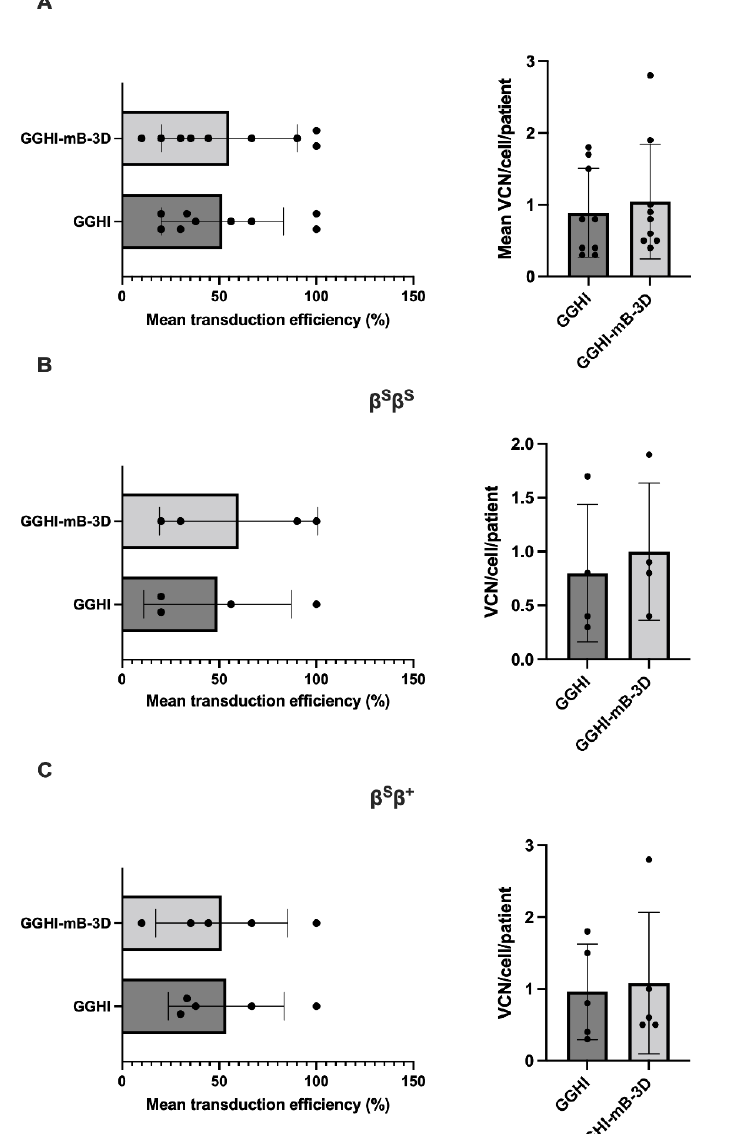
Figure 4. Transduction efficiency and VCN/cell demonstrated by γ -globin LVs in SCD CD34 + cells: ( A ) Scatter plots showing mean percentage of transduction efficiency (left) and mean VCN/cell/patient (right) across all patients and following transduction with GGHI and GGHI-mB-3D LVs at MOI 100. GGHI leads to 52 ± 31.5% and GGHI-mB-3D to 55 ± 35% transduction efficiency ( p = 0.82, n = 9, unpaired two-tailed t -test). Mean VCN/cell/patient for GGHI and GGHI-mB-3D is 0.89 ± 0.62 and 1.04 ± 0.8, respectively ( p = 0.65, n = 9, unpaired two-tailed t -test). ( B ) Scatter plots showing mean percentage of transduction efficiency (left) and mean VCN/cell/patient (right) in the β S β S patient cohort and following transduction with GGHI and GGHI-mB-3D LVs at MOI 100. GGHI leads to 49 ± 38% and GGHI-mB-3D to 60 ± 40.82% transduction efficiency ( p = 0.71, n = 4, unpaired two-tailed t -test). Mean VCN/cell/patient for GGHI and GGHI-mB-3D is 0.8 ± 0.64 and 1 ± 0.66, respectively ( p = 0.67, n = 4, unpaired two-tailed t -test). ( C ) Scatter plots showing mean percentage of transduction efficiency (left) and mean VCN/cell/patient (right) in the β S β + patient cohort and following transduction with GGHI and GGHI-mB-3D LVs at MOI 100. GGHI leads to 54 ± 30% and GGHI-mB-3D to 51 ± 34% transduction efficiency ( p = 0.91, n = 5, unpaired two-tailed t -test). Mean VCN/cell/patient for GGHI and GGHI-mB-3D is 0.96 ± 0.67 and 1.1 ± 0.98, respectively ( p = 0.83, n = 5, unpaired two-tailed t -test). Each dot corresponds to each patient. Error bars represent ±